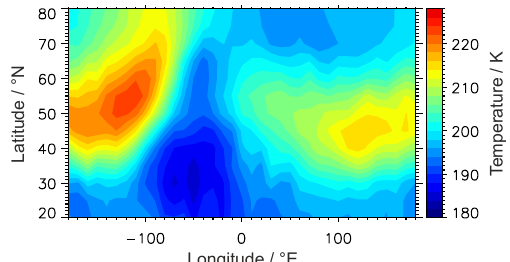
Figure 7. Latitude–longitude cross section of MLS temperatures at 80km altitude. The picture is a composite of all MLS observations gridded to latitude and longitude bins averaged for the time between 21 December 2015 and 5 January 2016.